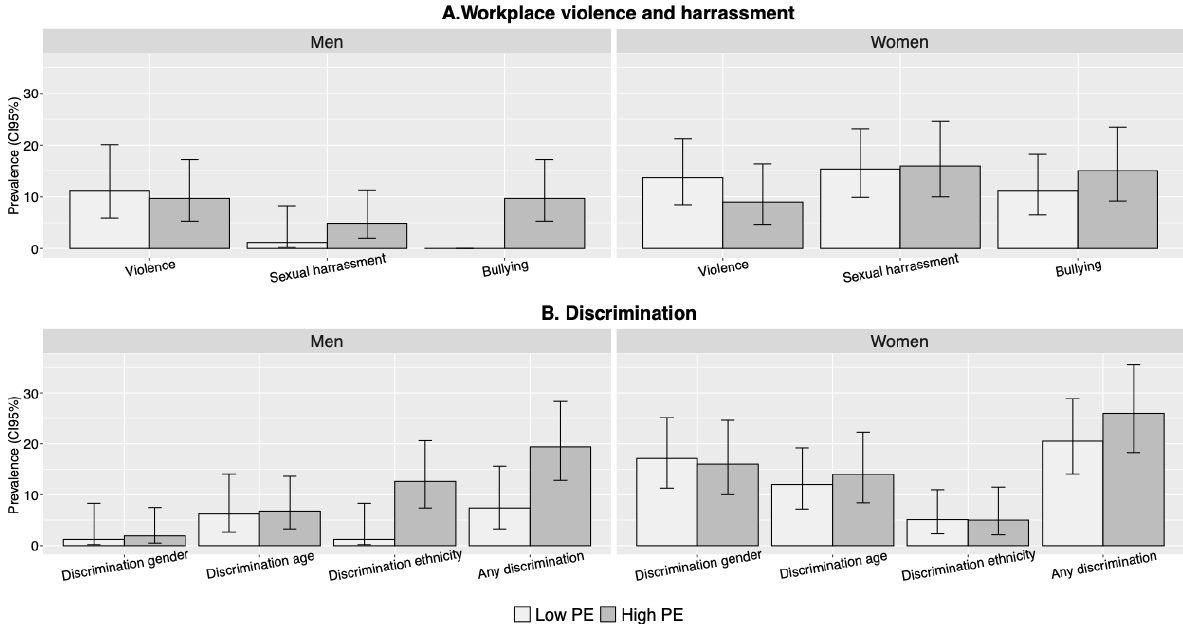
Figure 2. Prevalence of workplace violence, sexual harassment, and discrimination, according to gender and level of PE. ( n = 401).